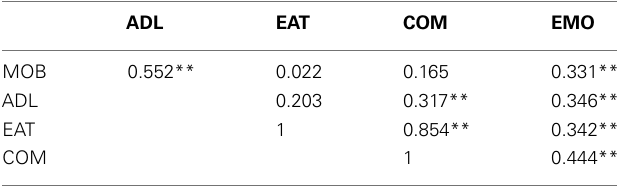
Table 5 | Correlation between areas at the second evaluation.